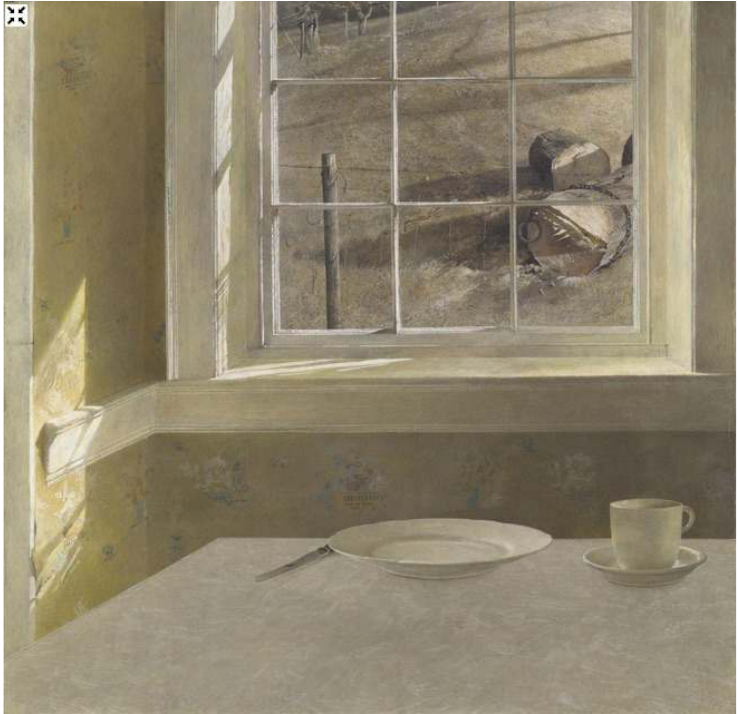
Figure 16. Andrew Wyeth, Groundhog Day . Tempera on panel